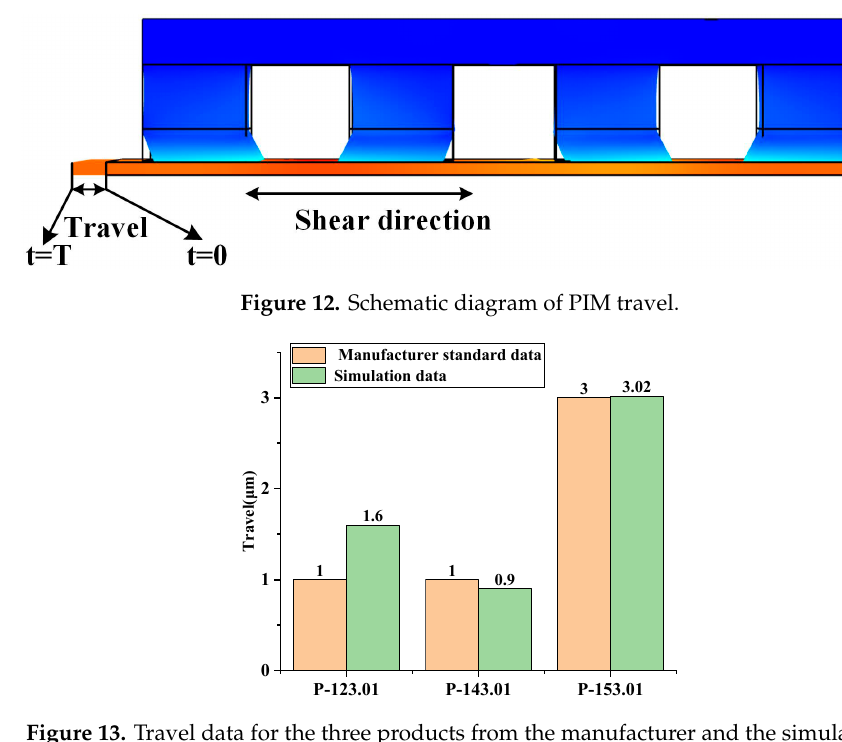
Figure 13. Travel data for the three products from the manufacturer and the simulation.